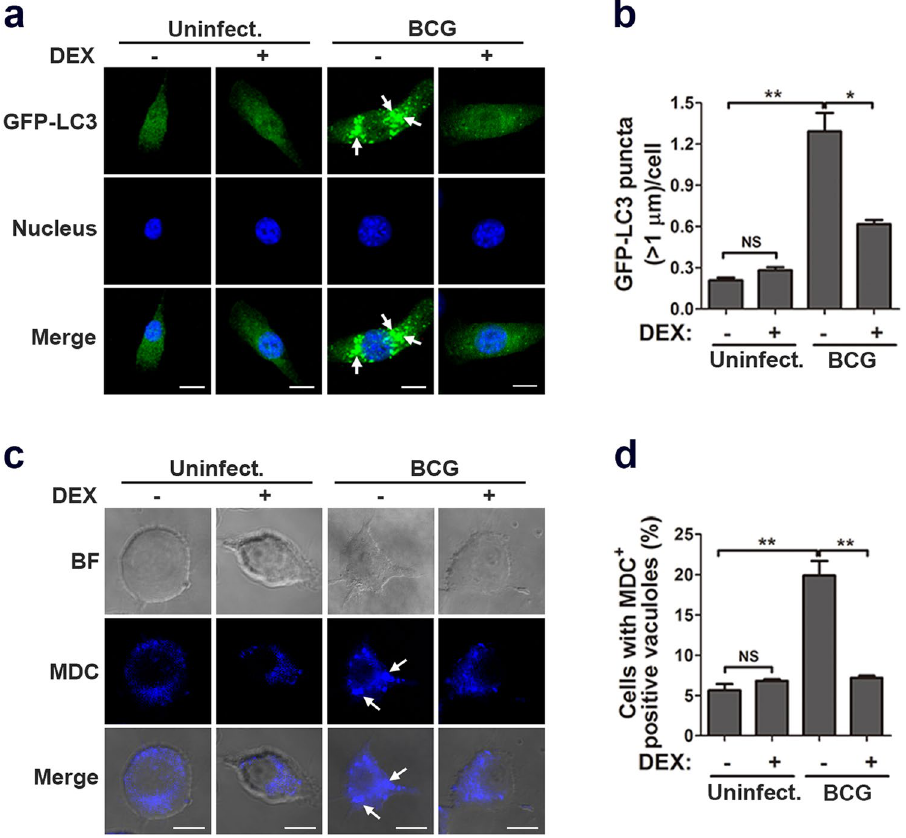
Figure 2. Glucocorticoids decrease autophagosome formation in mycobacteria-challenged macrophages. ( a , b ) RAW264.7 cells stably expressing GFP-LC3 were pretreated with dexamethasone (DEX) (1 μ M) or vehicle control ethanol (mock) for 6 hr and then challenged with M. bovis BCG (MOI 5) for 24 hr. Nuclei were stained with DAPI (blue), and GFP-LC3 puncta were monitored with fluorescence microscopy ( a ). The average number of GFP-LC3 puncta ( > 1 μ m) per cell was counted in at least 200 cells ( b ). ( c , d ) RAW264.7 cells were pretreated with DEX (1 μ M) or vehicle control ethanol (mock) for 6 hr and then challenged with M. bovis BCG (MOI 5) for 24 hr. Autophagosomes were detected with MDC staining ( c ). The percentage of MDC vacuole-positive cells was calculated in at least 200 cells ( d ). Arrows indicate the GFP-LC3 puncta or MDC-positive vacuoles. Scale bar, 5 μ m. * p < 0.05; ** p < 0.01. NS, not